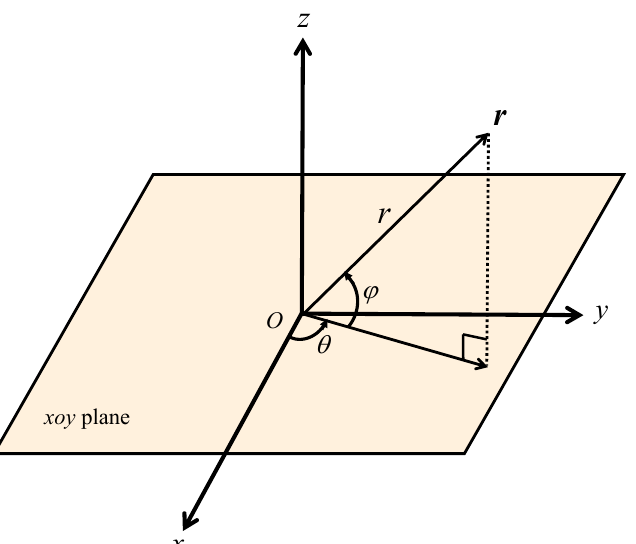
Figure 1. Illustration of the spherical